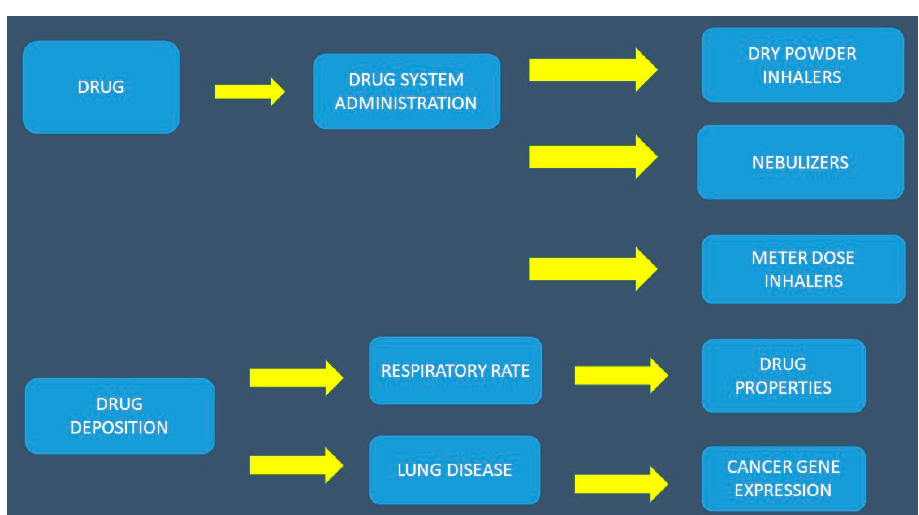
Figure 1. Parameters affecting the optimal drug administration. The dry powder inhalers and meter dose inhalers need specific use with simultaneous coordination of inhalation and device activation for efficient drug deposition. Nebulizers do not need specific device use; they only require deep inhalations and a slow respiratory rate. Drug deposition is a ff ected by local genes in the respiratory tract but also from the tumor genes. Drug properties are also responsible for the local and systematic absorption of an inhaled